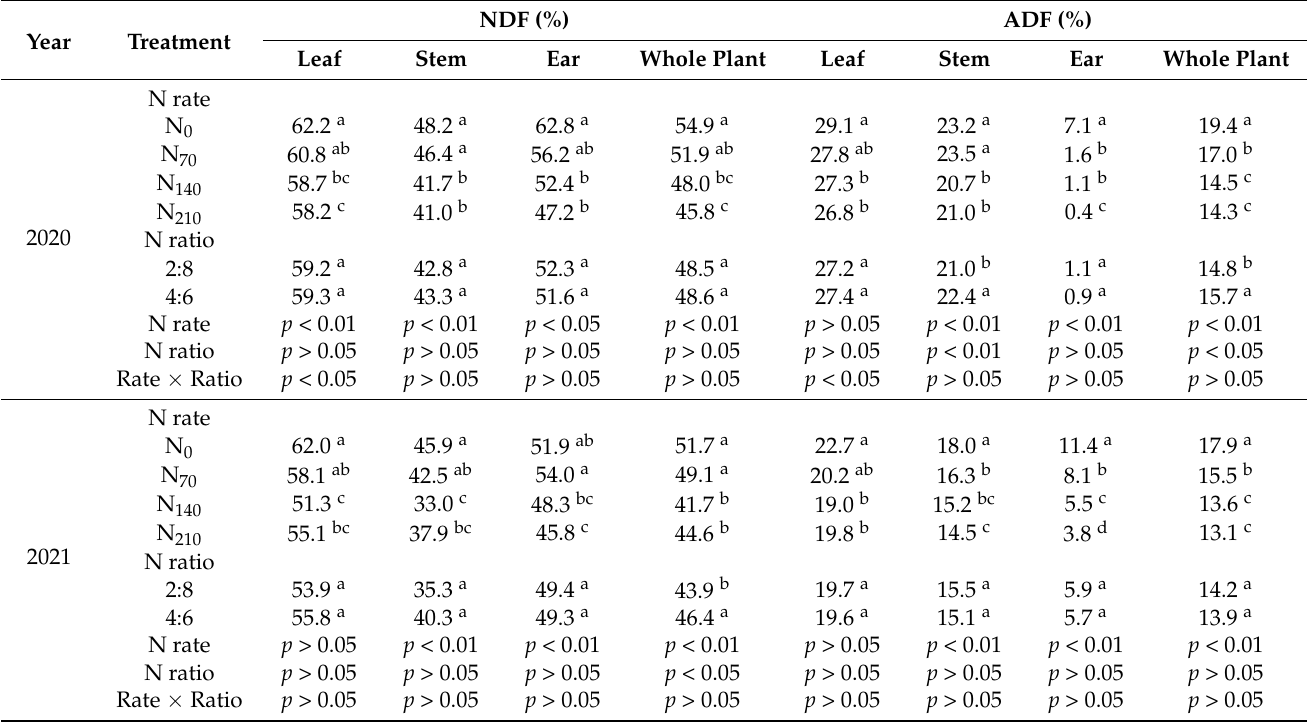
Table 5. Effects of different fertilization rates and basal topdressing ratios on NDF and ADF in 2020 and 2021.